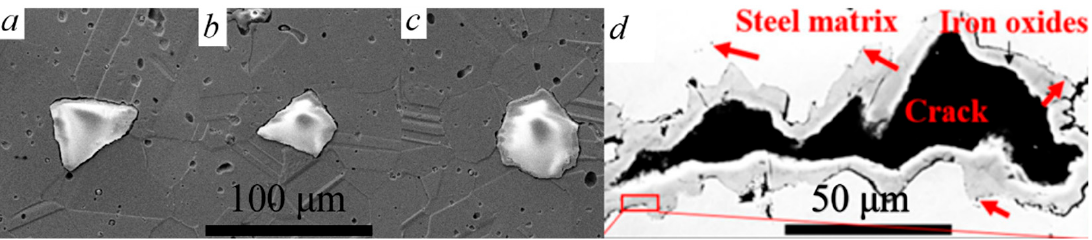
Figure 1. ( a ) Triangle-shaped inclusion, ( b ) quadrilateral-shaped inclusion, ( c ) polygonal-shaped inclusion [21,22], and ( d ) macrostructure of the hole, iron oxide, and steel matrix [28].